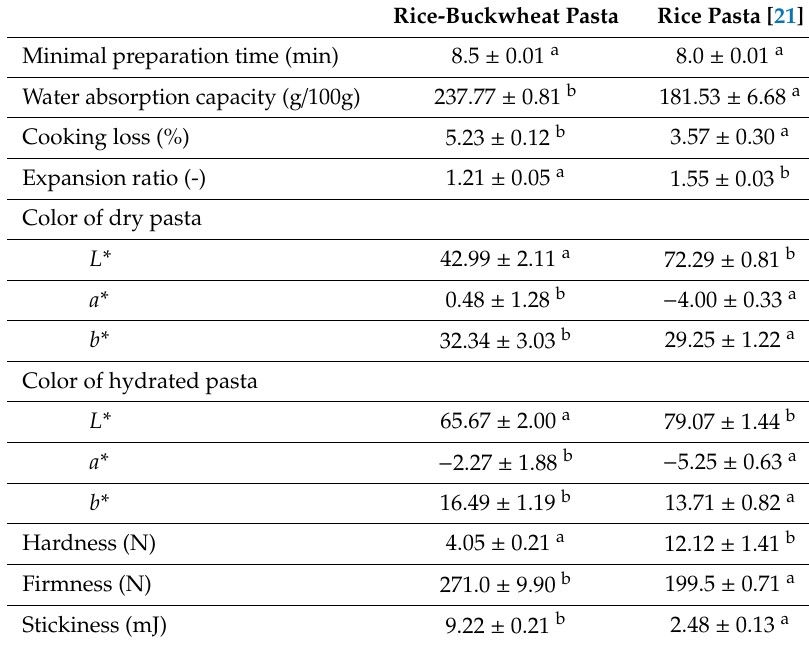
Table 5. Characteristics of Optimum Rice-Buckwheat Pasta in Comparison to Rice